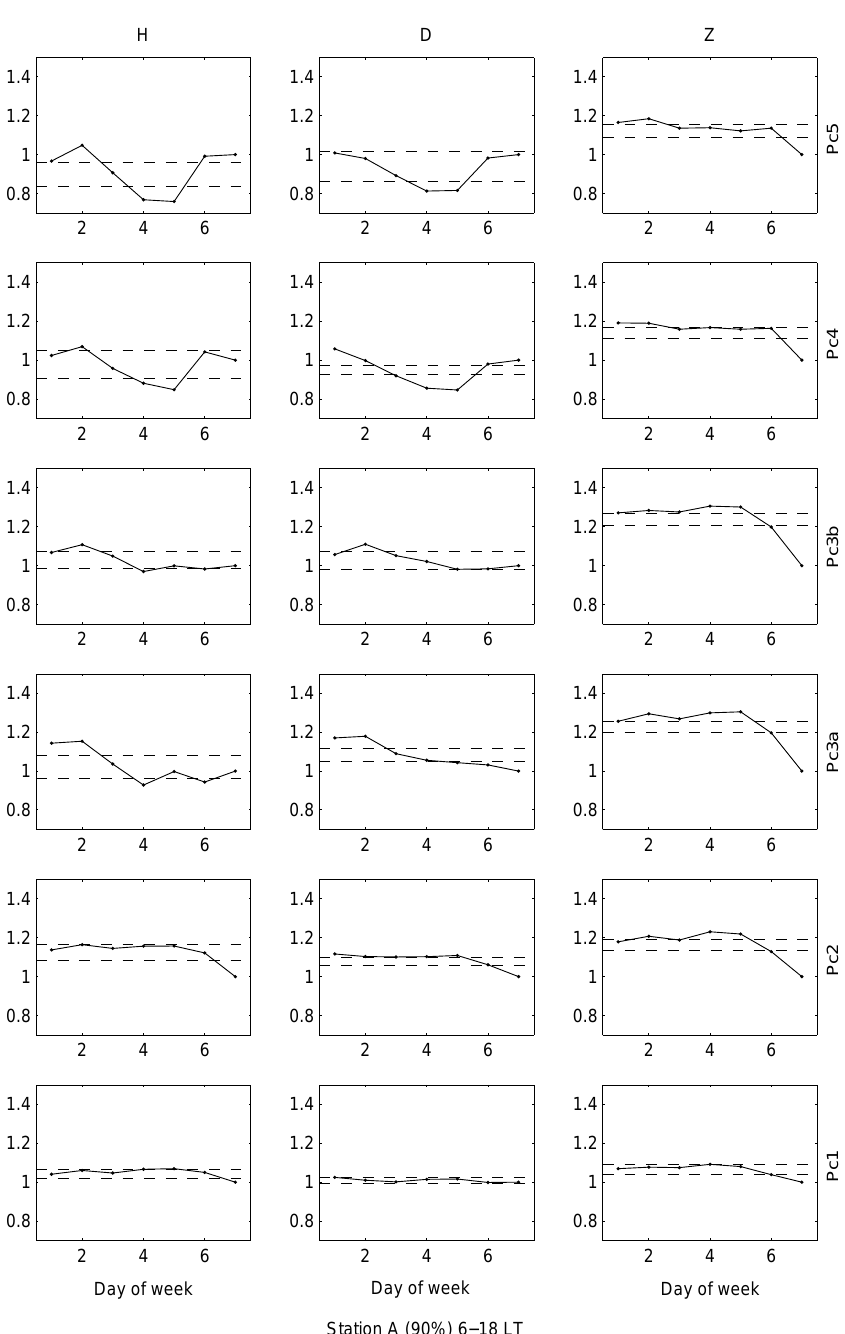
Fig. 1. Weekly variation of the average daytime power of magnetic field components in different frequency bands at Station A (90% of original spectra). Dashed lines identify the 99% confidence